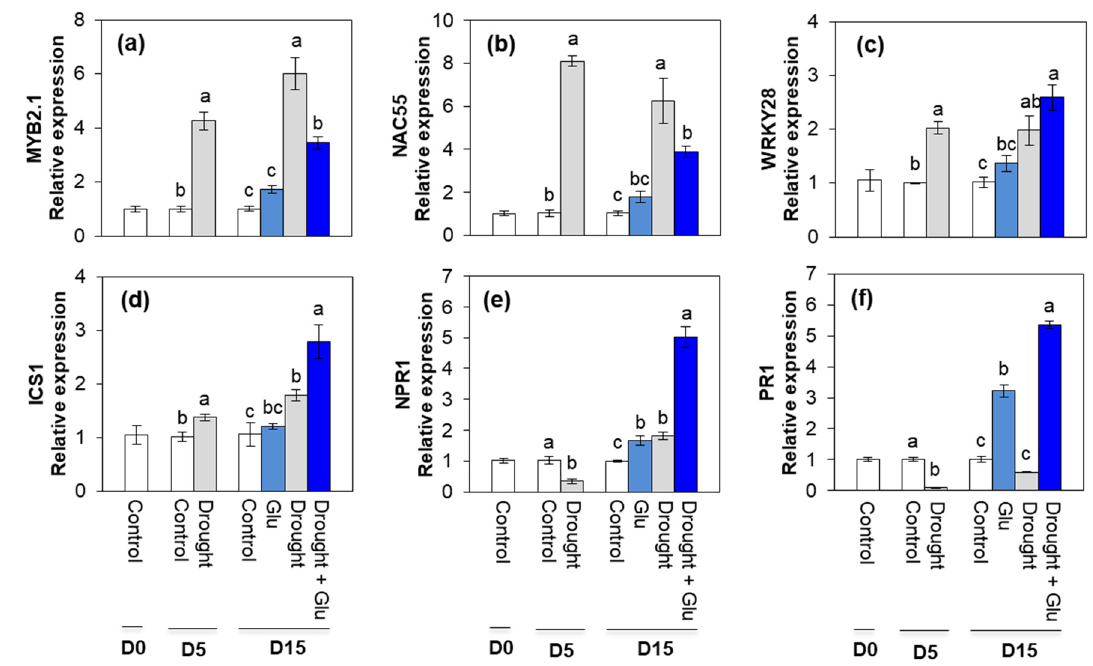
Figure 3. Effects of glutamate (Glu) application on the expression of ABA-responsive genes (( a ) myb-like transcription factor ( MYB2.1 ) and ( b ) NAC domain-containing protein 55 ( NAC55 )), SA-synthesis related gene (( c ) WRKY transcription factor 28 ( WRKY28 ) and ( d ) isochorismate synthase 1 ( ICS1 )), and SA-responsive genes (( e ) non-expressor of pathogenesis-related (PR) gene ( NPR1 ) and ( f ) PR1 ) in the leaves of Brassica napus under well-watered or drought-stressed conditions. qRT-PCR was performed in duplicate for each of the three independent biological samples. Values are represented as mean ± SE ( n = 3). Different letters on columns indicate significant difference at p < 0.05 according to Duncan’s multiple range test.